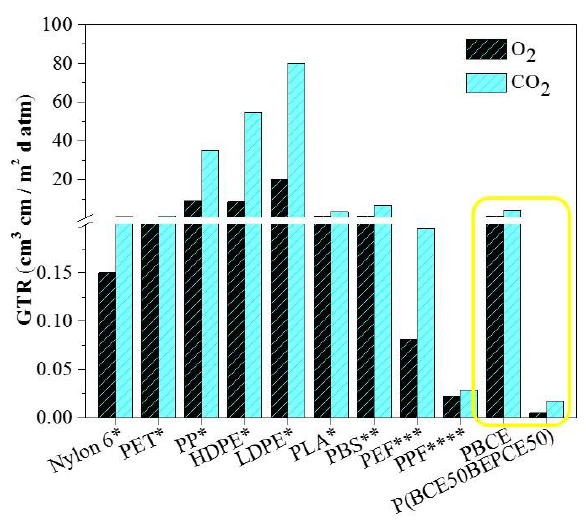
Figure 9. Gas transmission rate of O 2 and CO 2 gases for PBCE and P(BCE 50 BEPCE 50 ) and for some traditional petrochemical-based polymeric packaging materials and for some biopolymers (poly(ethylene terephthalate) PET, polypropylene PP, high density polyethylene HDPE, low density polyethylene LDPE, polylactic acid PLA, poly(butylene succinate) PBS, poly(ethylene furanoate) PEF, poly(propylene furanoate) PPF) from References [26 – 30].